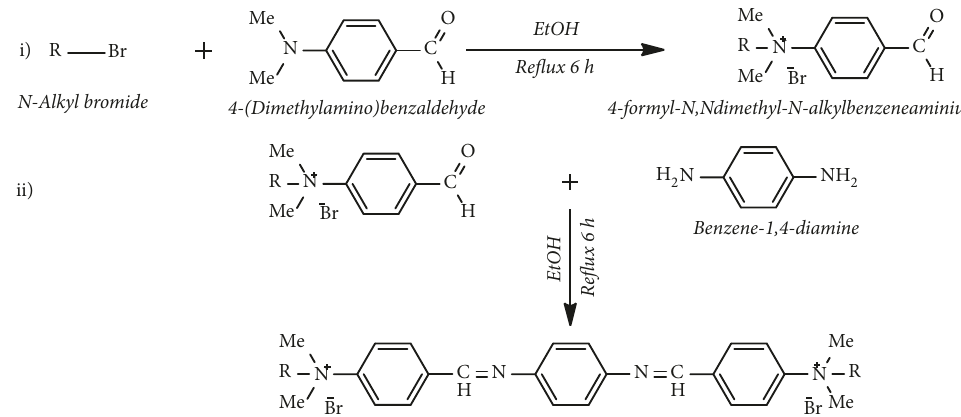
Figure 1: Schematic synthesis of A312, A314 and A316. n = 10 { A 312} 4,4-[1,4phenylenebis(azanylylidene)bis(N,N-dimethyl-N- dodecylaminium] bromide. n = 12 { A 314} 4,4-[1,4phenylenebis(azanylylidene)bis(N,N-dimethyl-N-tetradecylaminium] bromide. n = 14 { A 316} 4,4-[1,4phenylenebis(azanylylidene)bis(N,N-dimethyl-N-hexadecylaminium]